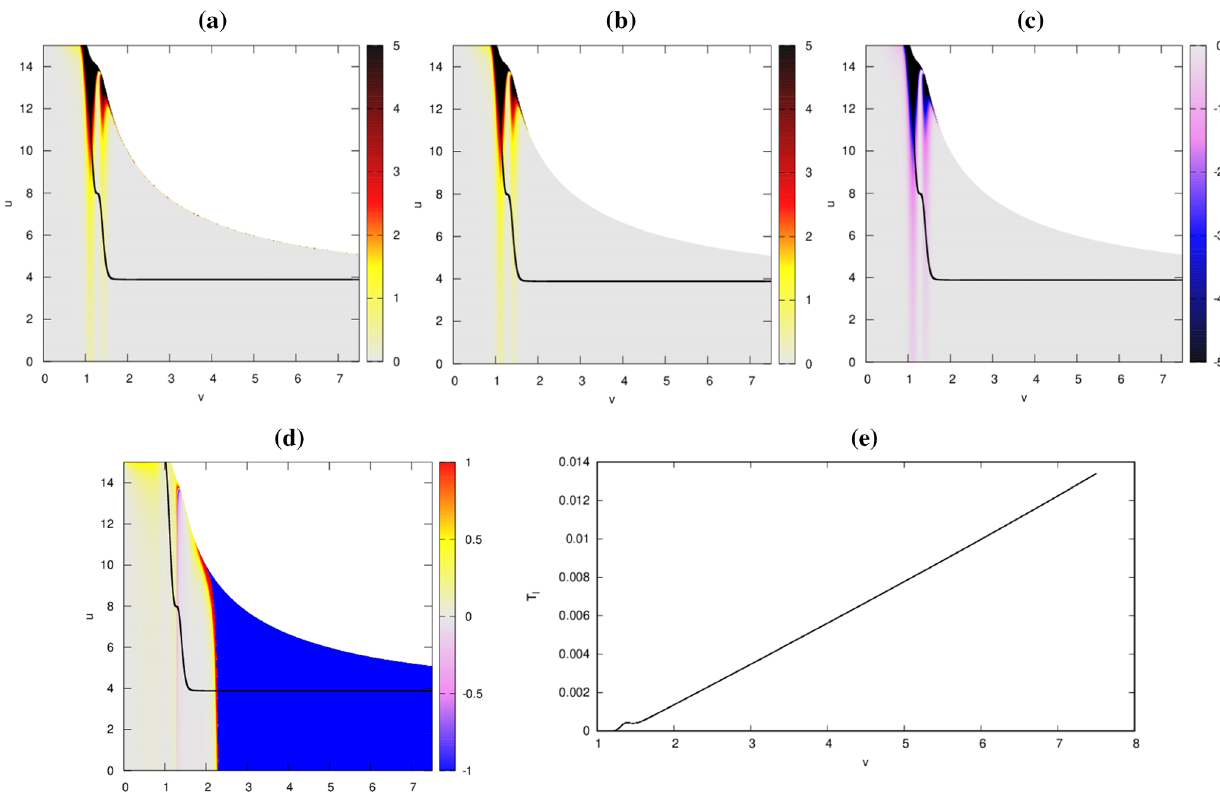
Fig. 15 The (v u ) -distribution of a energy density, ˆ ρ , b radial pressure, ˆ p ˆ p r , c pressure anisotropy, a , d tangential to radial pressures ratio, and e local temperature along the black hole apparent horizon, T l , as